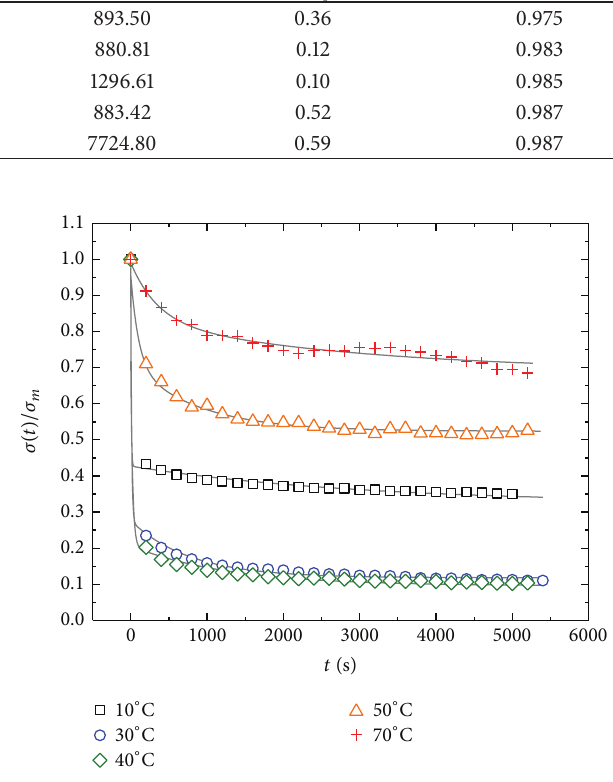
Figure 9: Modeling of relaxation curves for ESTANE with the modified Maxwell-Zener